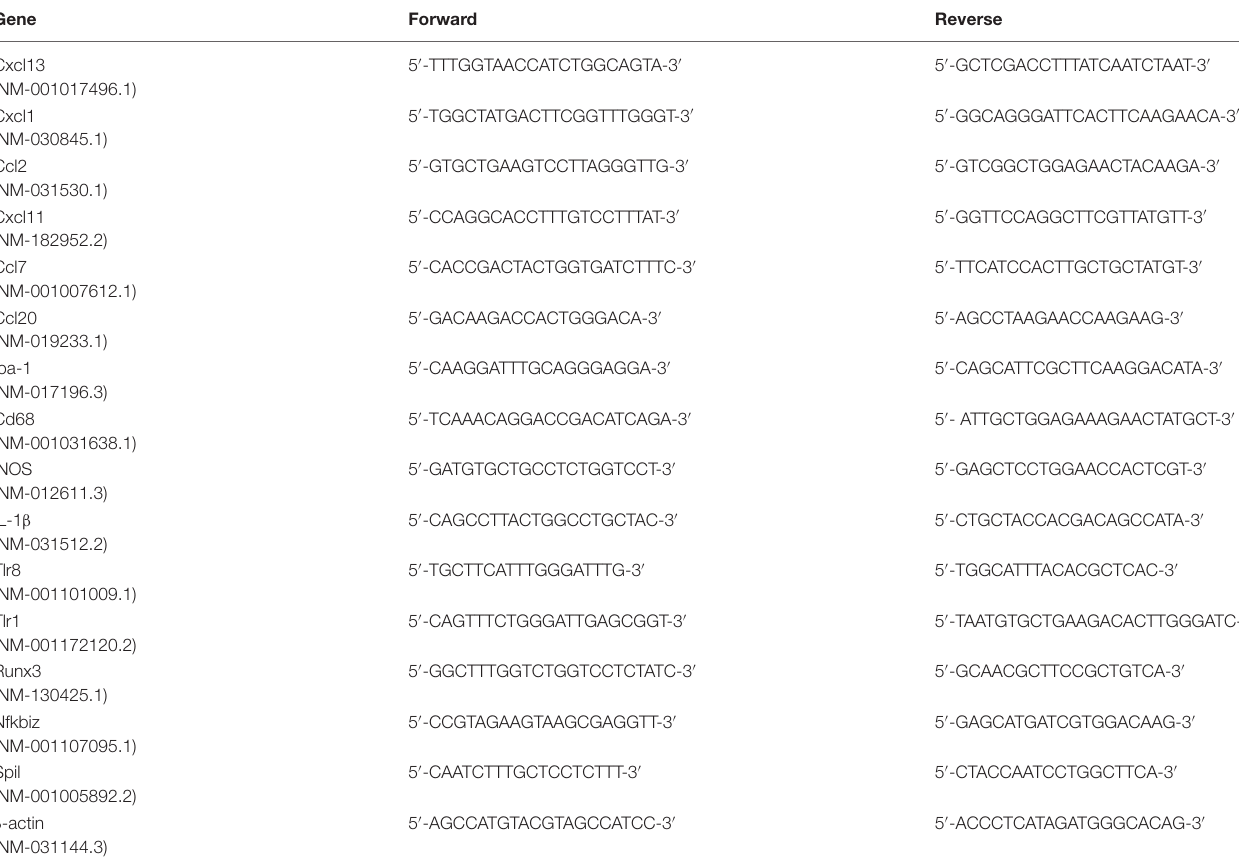
TABLE 1 | Primers used for RT-PCR. Gene Forward